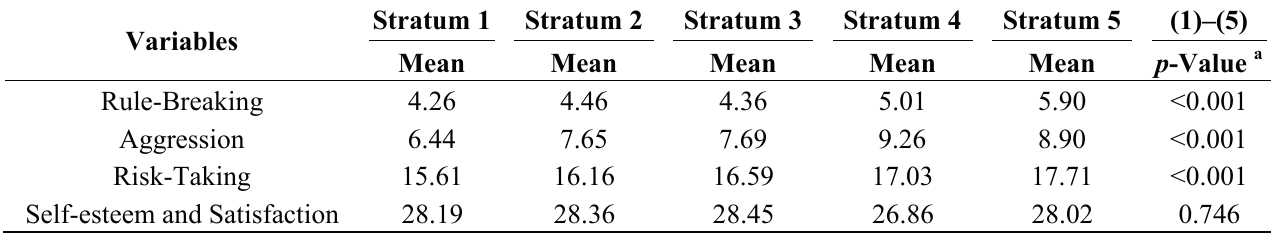
Table 6. Evidence of Selection-Based Stratification ( N =